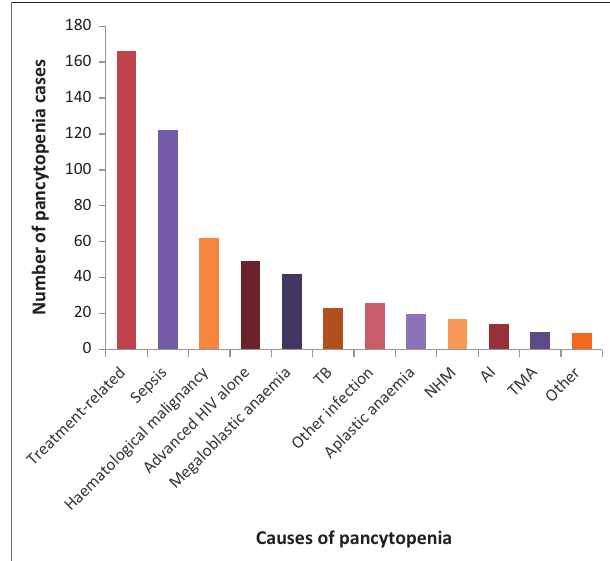
FIGURE 2: Frequency of different causes of pancytopenia among adult patients at Tygerberg Academic Hospital, Cape Town, South Africa, from January 2016 to December 2017. Note: Top five causes: Chemoradiation therapy (25 % ); Sepsis (18 % ); Haematological malignancy (9 % ); Advanced HIV (7 % ); Megaloblastic anaemia (6 % ). Other infections include malaria, cytomegalovirus, parvovirus B19, Epstein-Barr virus and hepatitis B